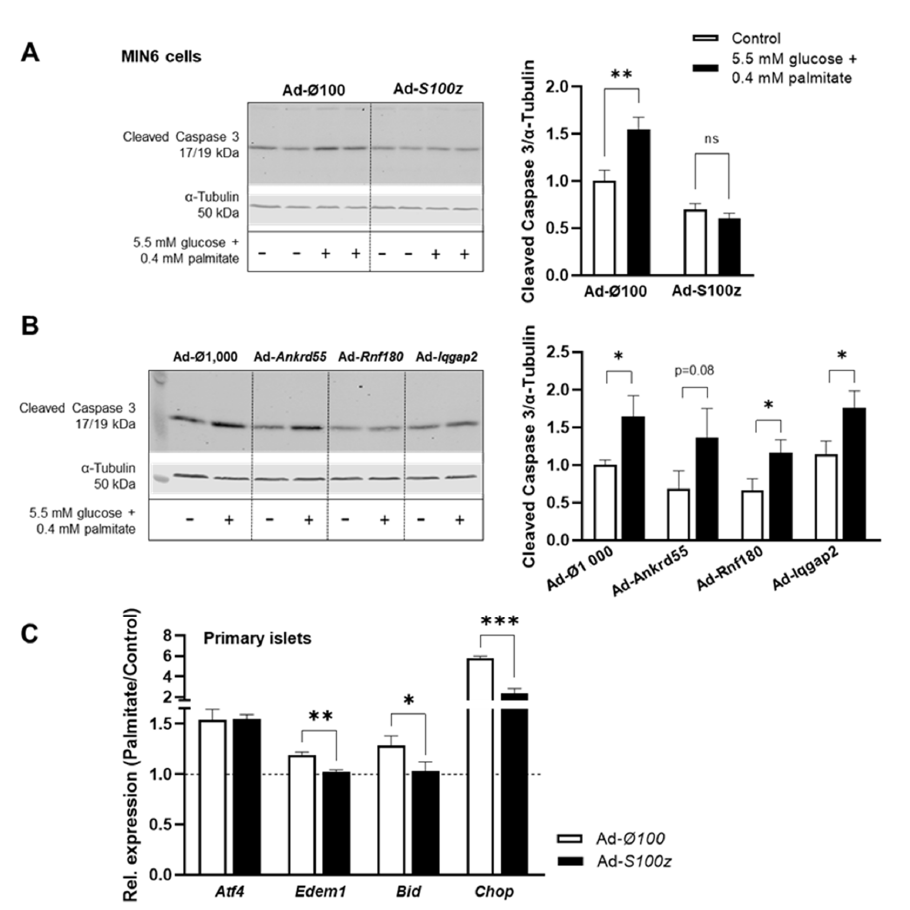
Figure 5. Effect of Nidd13/NZO candidate genes on apoptosis. Representative images displaying the effect of MIN6 cells infected with ( A ) Ad- S100z vs. Ad- ∅ 100 and ( B ) Ad- Ankrd55 , Ad- Rnf180 , and Ad- Iqgap 2 vs. Ad- ∅ 1000 on protein levels of cleaved caspase-3 as a marker for apoptosis. Infected cells ( n = 6–8) were stressed with 0.4 mM palmitate for 48 h, and protein levels of cleaved caspase-3 were analyzed and quantified by Western blotting. Here, α -tubulin was used as loading control. ( C ) Primary islet cells of NZO mice were infected with Ad- S100z or Ad- ∅ 100 and incubated with 0.4 mM palmitate for 48 h. Expression of ER-stress and apoptotic marker genes were analyzed by qRT-PCR. Data are presented as fold change compared to cells under basal conditions. Data are shown as means ± SEM. * p < 0.05; ** p < 0.005, *** p <